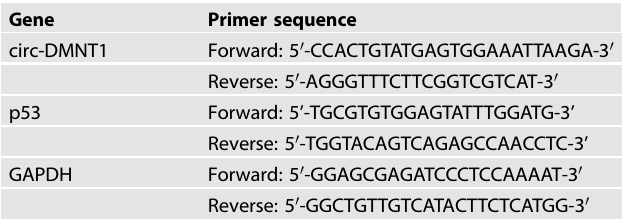
Table 1. The primers used in this study.